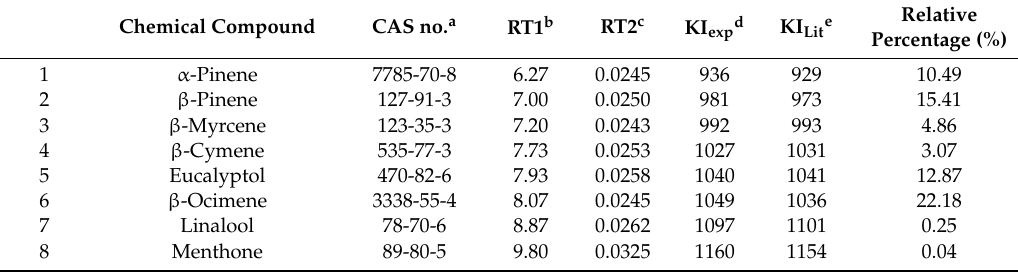
Table 1. Chemical constituents of KWM-EO determined by GC × GC-TOF